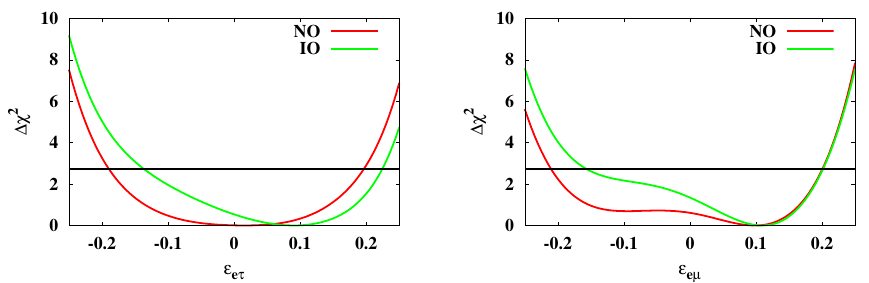
Figure 5 . Values of (cid:1) (cid:31) 2 for the cases of non-zero (cid:15) e(cid:28) (left panel) and (cid:15) e(cid:22) (right panel). Other NSI parameters except for (cid:15) e(cid:28) (left panel) and (cid:15) e(cid:22) (right panel) are set to zero. Red (dark gray) and green (light gray) lines correspond to NO and IO, respectively.